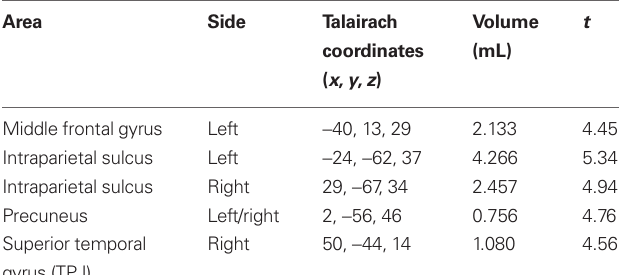
Table 3 | Regions of cortex that are active for the contrast Distractor Present trials > Distractor Absent trials, p < 0.001, corrected using a cluster threshold of 19 contiguous